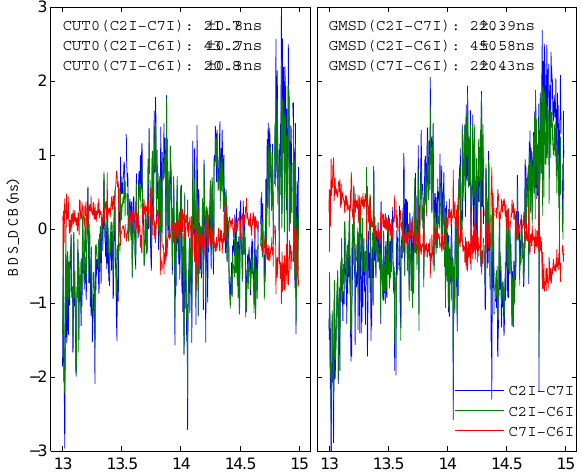
Figure 10. Two-year RMS of GPS minus BDS DCBs (C2I– C7I/CIC–C2W) estimated from MGEX and BETS network obser- vations corresponding to the 18 selected stations.